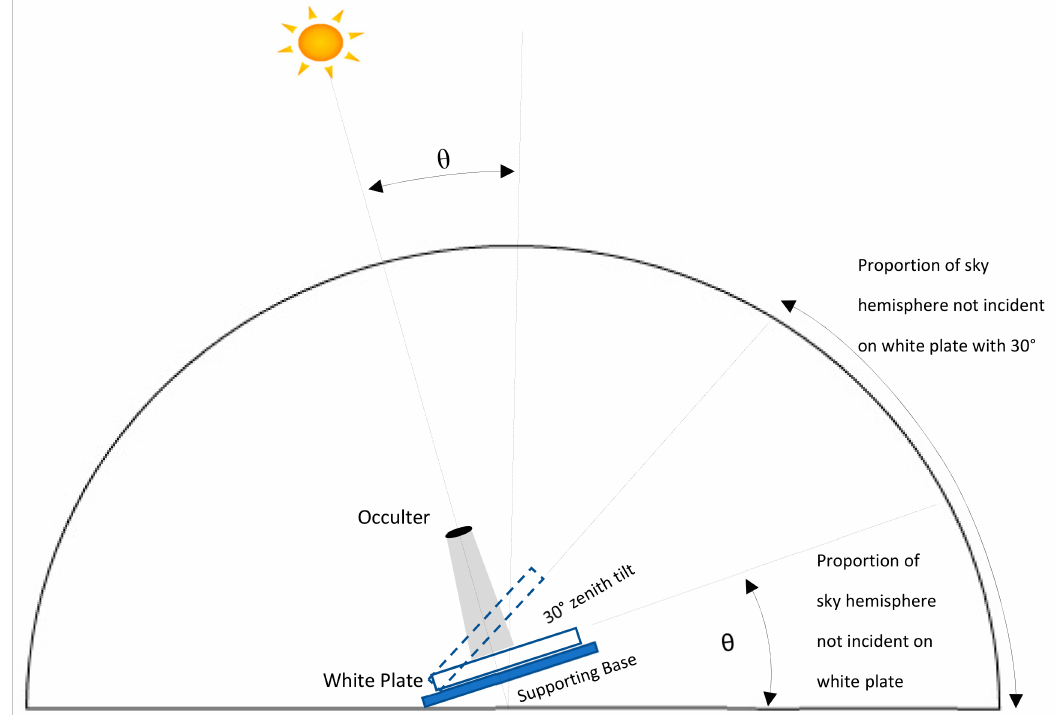
Figure 4. Sky hemisphere incident upon reference panel with supporting base normal to the Sun compared to sky hemisphere when reference panel tilted at 30 ◦